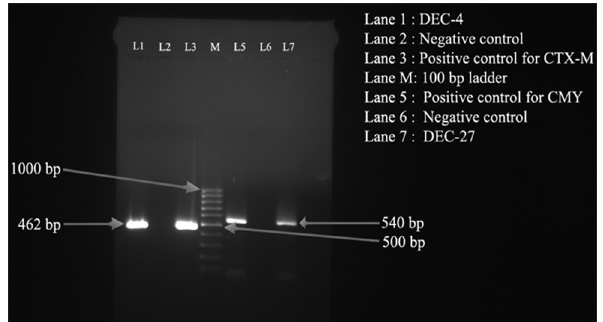
Figure-2: Polymerase chain reaction-based detection of bla (462 bp) and bla (540 bp) genes Escherichia coli CTX-M CMY isolated from pigs of NER starts of India. Lane 1: DEC-4; Lane 2: Negative control; Lane 3: Positive control for CTX- M; Lane M: 100 bp DNA ladder; Lane 5: Positive control for CMY; Lane 6: Negative control; and Lane 7: DEC-27.